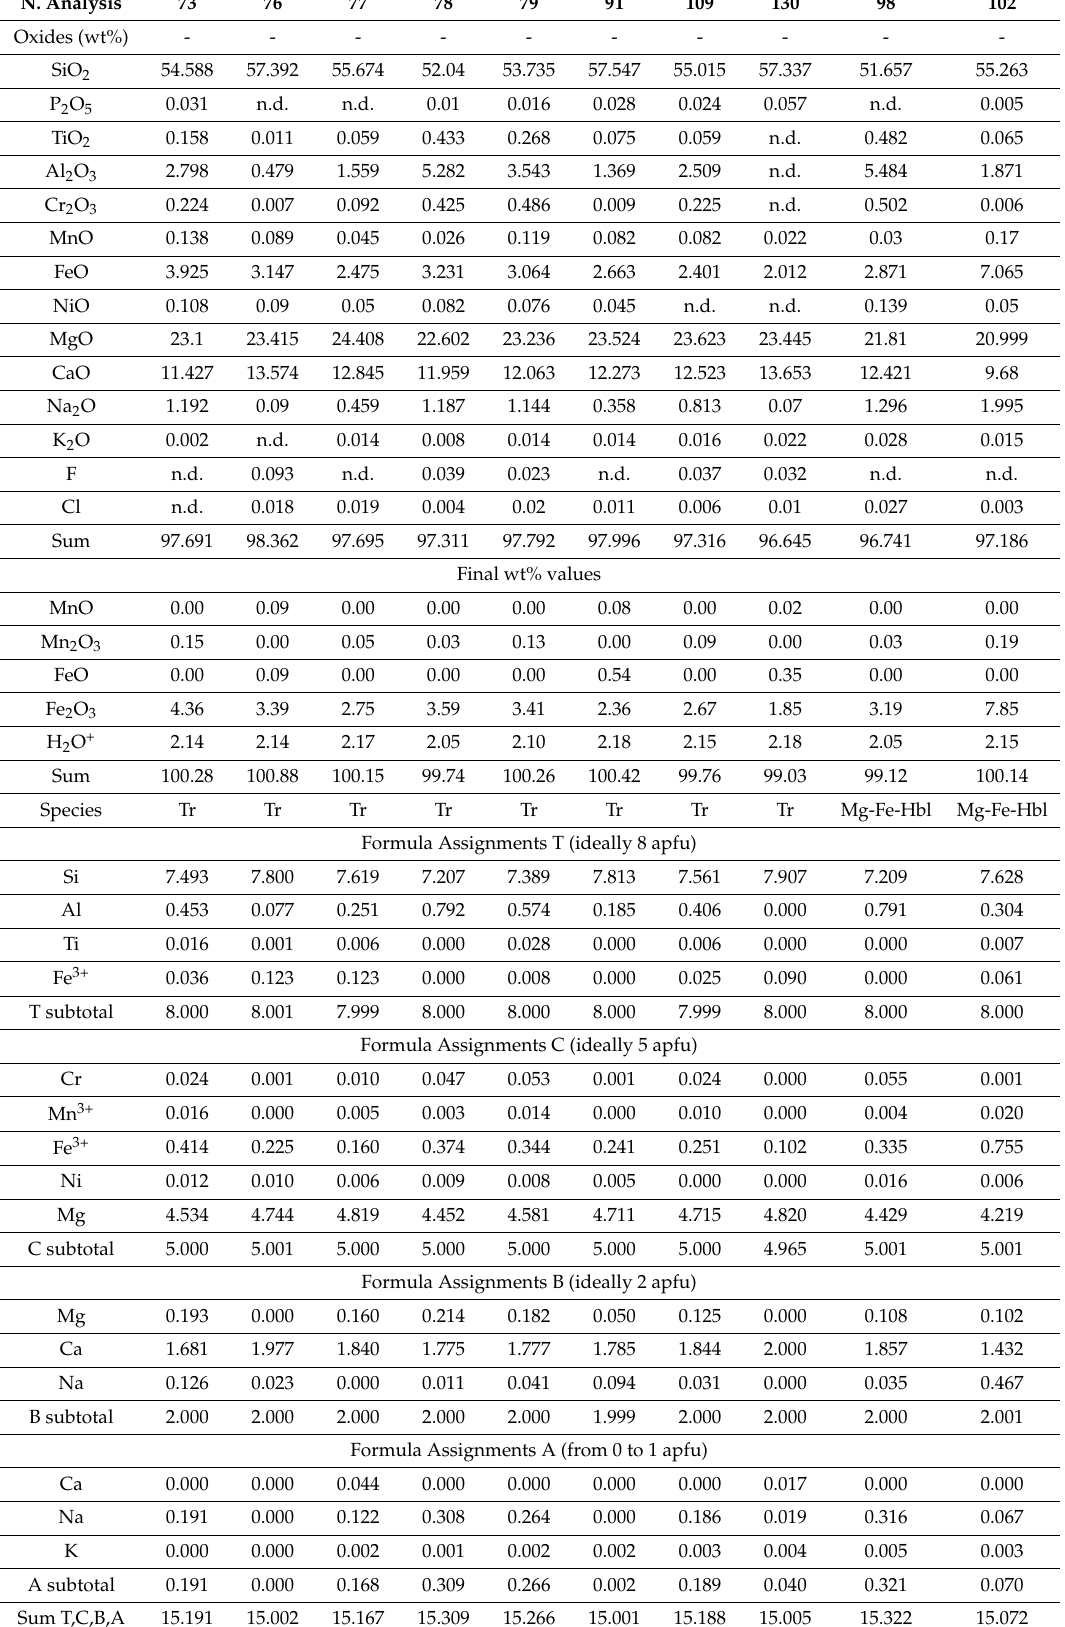
Table 3. Chemistry of selected fibrous tremolite and Mg-Fe-hornblende crystals in the serpentinites of the Pollino